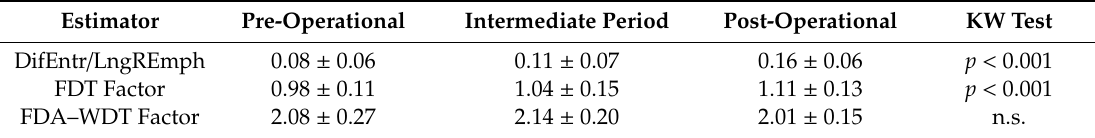
Table 5. Selected calculation used for evaluation recurrence rate. Estimator